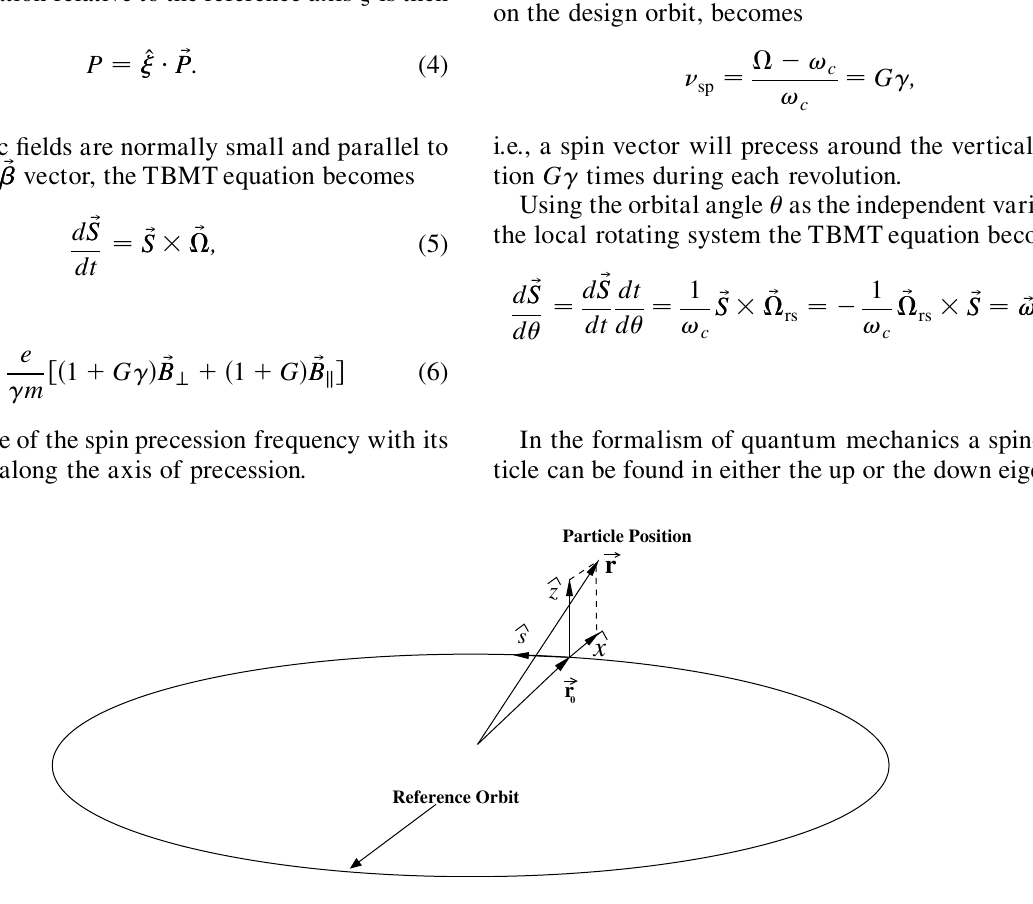
The curvilinear coordinate system for particle motion in a synchrotron. Here ^ xx , ^ ss , and ^ zz are, respectively, the transverse radial, longitudinal, and transverse vertical unit basis vectors, and ~rr